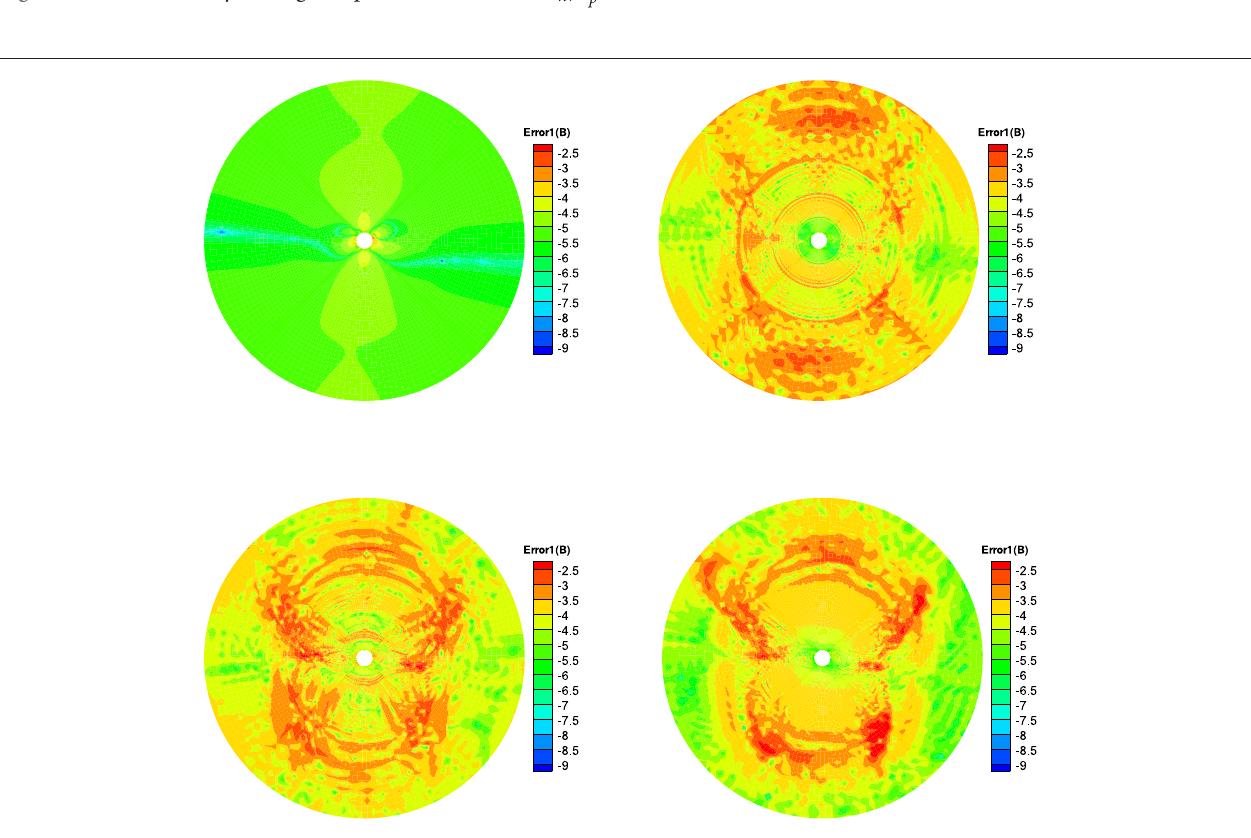
FIGURE 7 | The log 10 Error1 (B) in the calculation at t = 5 h on the meridional plane of φ = 180 ◦ − 0 ◦ from 1 to 20 R s , the results from CT method (left) and diffusive method (right) are displayed in the top row, the bottom row is from the projection method (left) and GLM method (right).